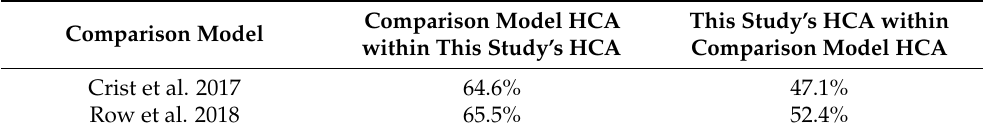
Table 3. Percent agreement between high connectivity areas (HCA, i.e., pixels with current flow values in the top quartile for a given model) predicted by our sage-grouse connectivity model (this study) and those predicted by two existing sage-grouse connectivity models (comparison models). Model agreement was calculated as both the percentage of HCA predicted by each comparison model falling within HCA predicted by this study and the percentage of this study’s HCA falling within the HCA of each comparison